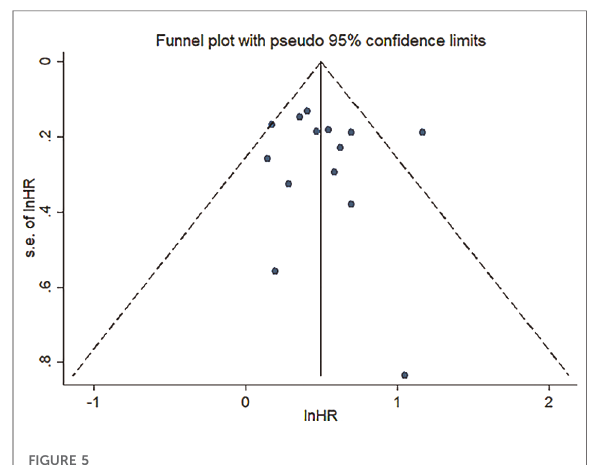
FIGURE 5 Funnel plot illustrating publication bias test